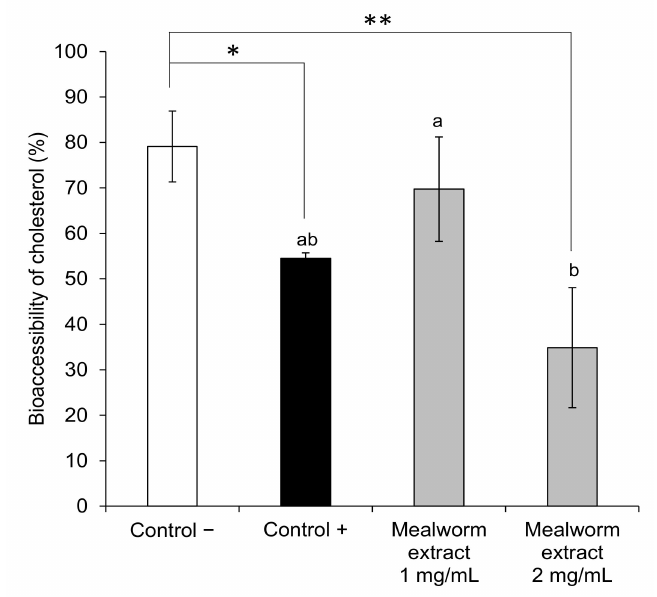
Figure 2. Bioaccessibility of cholesterol (%) after the gastrointestinal digestion of cholesterol in the absence (control –) and presence of inhibitors: β -sitosterol, as control + (at 1 mg/mL) and mealworm extract at 1 and 2 mg/mL. Bars are significantly different to control – when p = 0.014 (*) and p = 0.009 (**). Mean values with different letters (a − c) among inhibitors are significantly different if p ≤